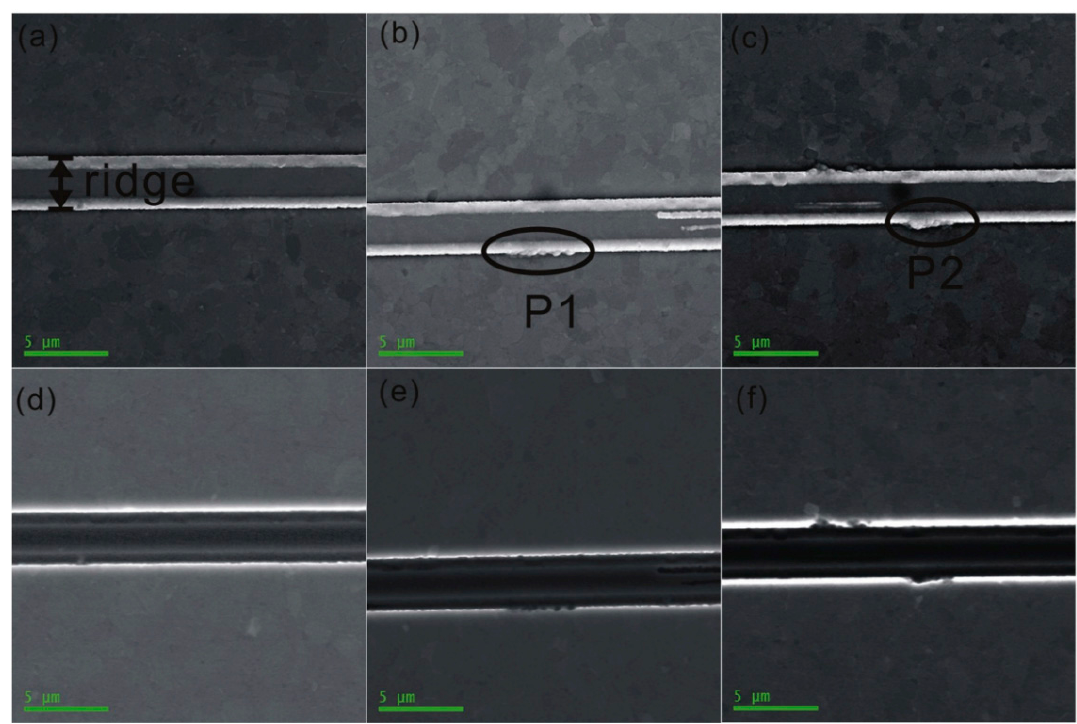
Figure 6. Typical secondary electron images of ( a ) non-aged LD and ( b ) and ( c ) rapidly degraded LD and the corresponding EBIC images of ( d ) non-aged LD and ( e ) and ( f ) rapidly degraded LD (the two black ovals mark two possible heavily degraded positions in the LD) [62]. Reprinted with permission from ref. [62] © Elsevier. Copyright 2020 Superlattices and Microstructures.